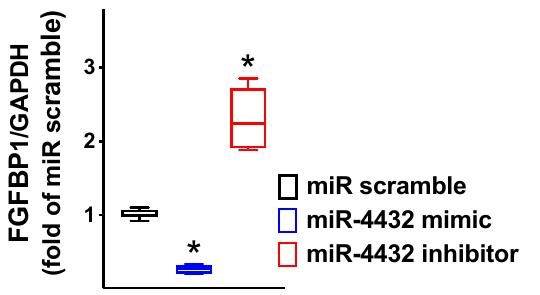
Figure 5. In hBMECs, FGFBP1 transcription was diminished by miR-4432 and augmented by miR- 4432 inhibitor. FGFBP1 mRNA was quantified via RT-qPCR in hBMECs that had been transfected for forty-eight hours with the miRs indicated in the figure; values were normalized to GAPDH (glyceraldehyde-3-phosphate-dehydrogenase). All the assays were carried out at least in triplicate; the graph shows the medians and the 5th to 95th percentiles; *: p < 0.01 vs. miR-scramble. Sequences of the primers that have been used for the RT-qPCR are shown in Table 1.